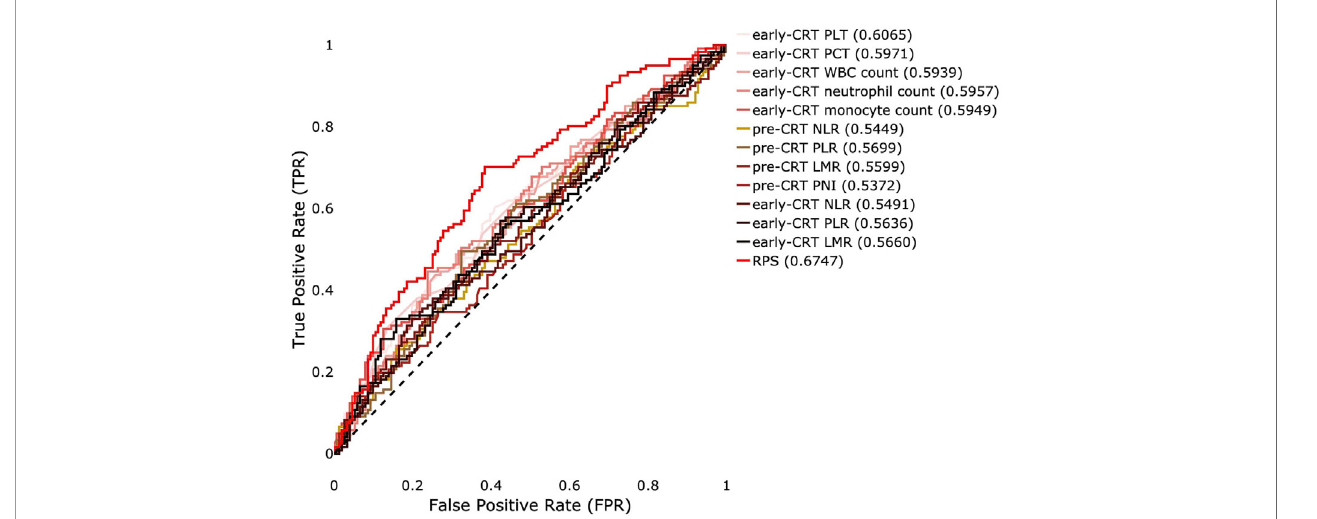
FIGURE 4 | ROC curves of signi fi cant single blood features and systemic in fl ammatory and nutritional indicators of pre- or early-CRT and the RPS system for binary prediction for the true label. A value in parentheses means AUROC.